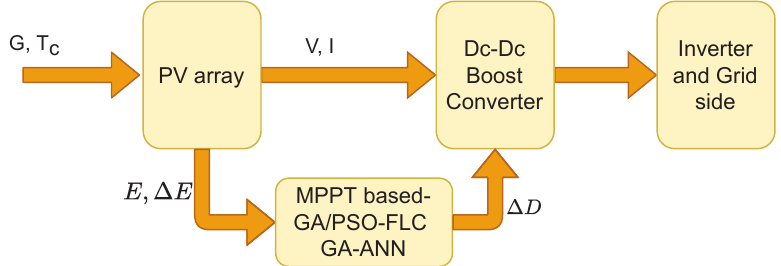
Figure 8. A schematic diagram of the grid-connected PV system.